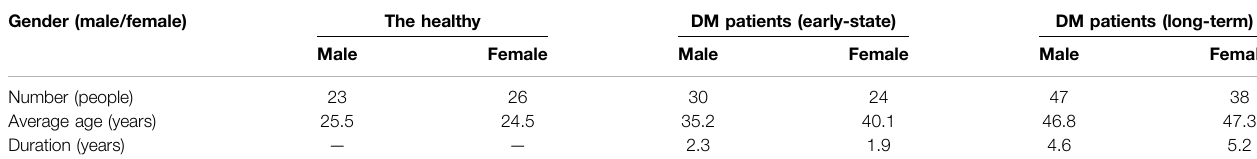
TABLE 1 | The detailed information of the subjects from the healthy and the DM patients. Gender (male/female)